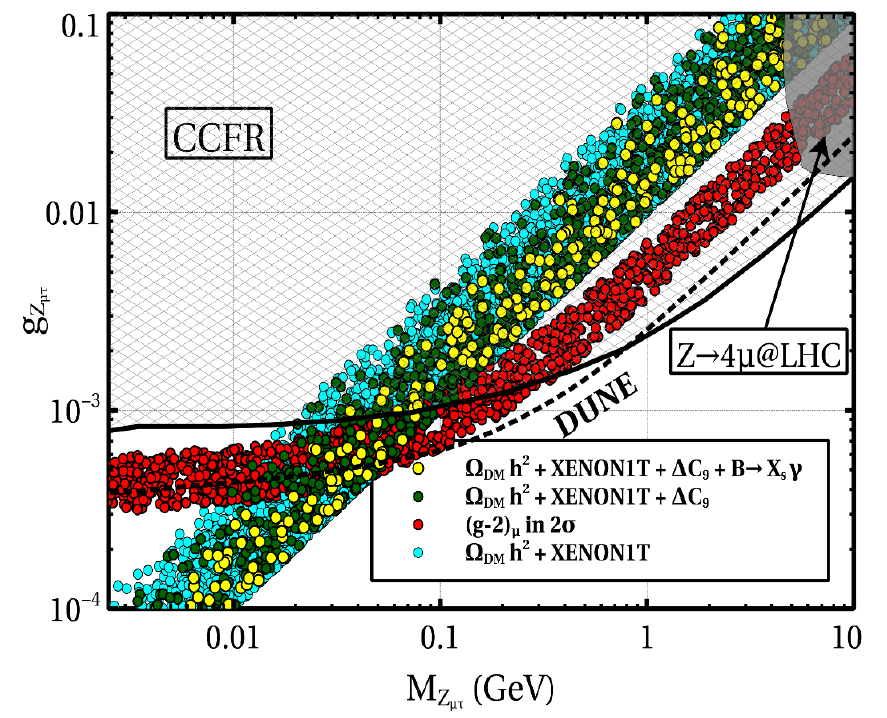
Figure 12 . Current status of the g Z M Z plane in the light of various experimental results. (cid:22)(cid:28) (cid:0) (cid:22)(cid:28) In this plane we have shown the allowed regions satisfying bounds from Planck + XENON1T (cyan coloured points), Planck + XENON1T + R anomalies (green coloured points) and Planck + K ( (cid:3) ) XENON1T + R anomalies + Br( B X s (cid:13) ) (yellow coloured points) respectively. Moreover, K ( (cid:3) ) ! red coloured points are indicating those values of M Z and g Z which address ( g 2) (cid:22) in 2 (cid:27) (cid:22)(cid:28) (cid:22)(cid:28) (cid:0) range. In this plot, we have also taken into account the invisible decay branching constraint of the SM-like Higgs boson H 1